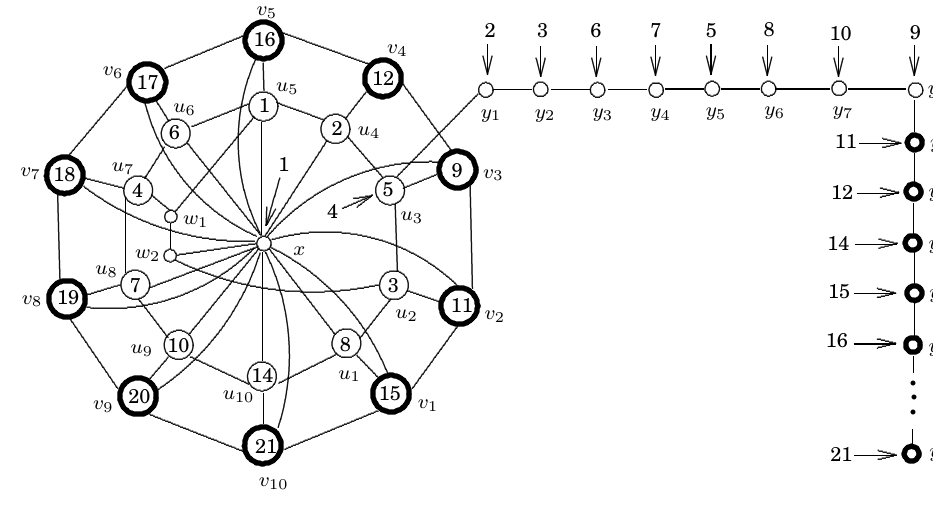
Figure 16: The graph G